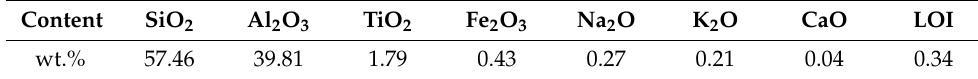
Table 1. Chemical components of metakaolin.